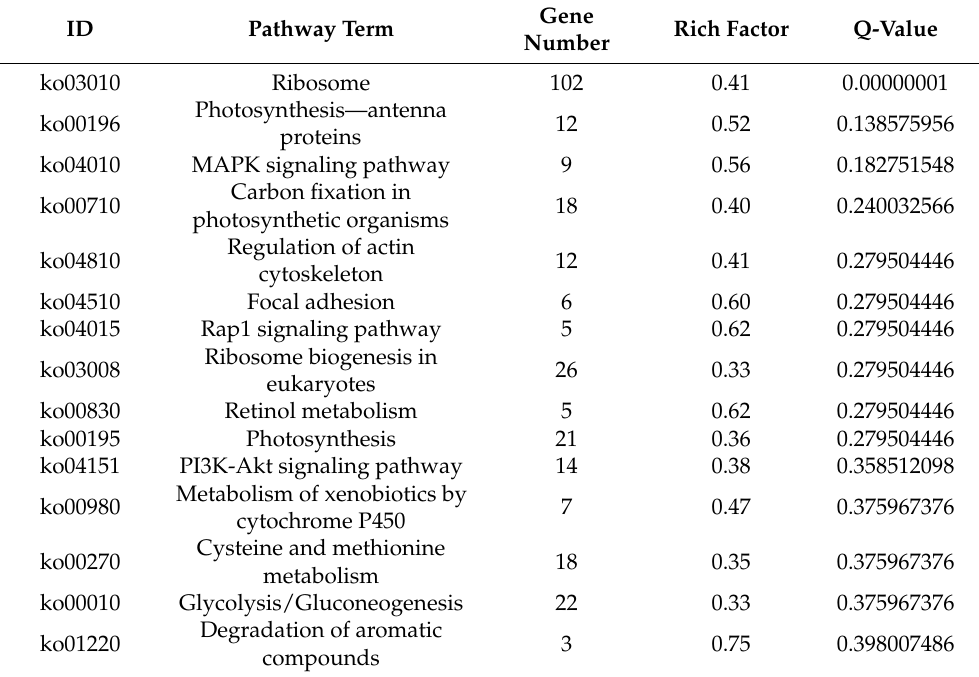
Figure 8. Enriched distribution point diagram of KEGG pathways for significant genes under salt-free condition. ( a ) Enriched pathways for down-regulated genes; ( b ) enriched pathways for up-regulated genes. Table 2. The top 15 enriched pathways of differentially expressed genes in KEGG